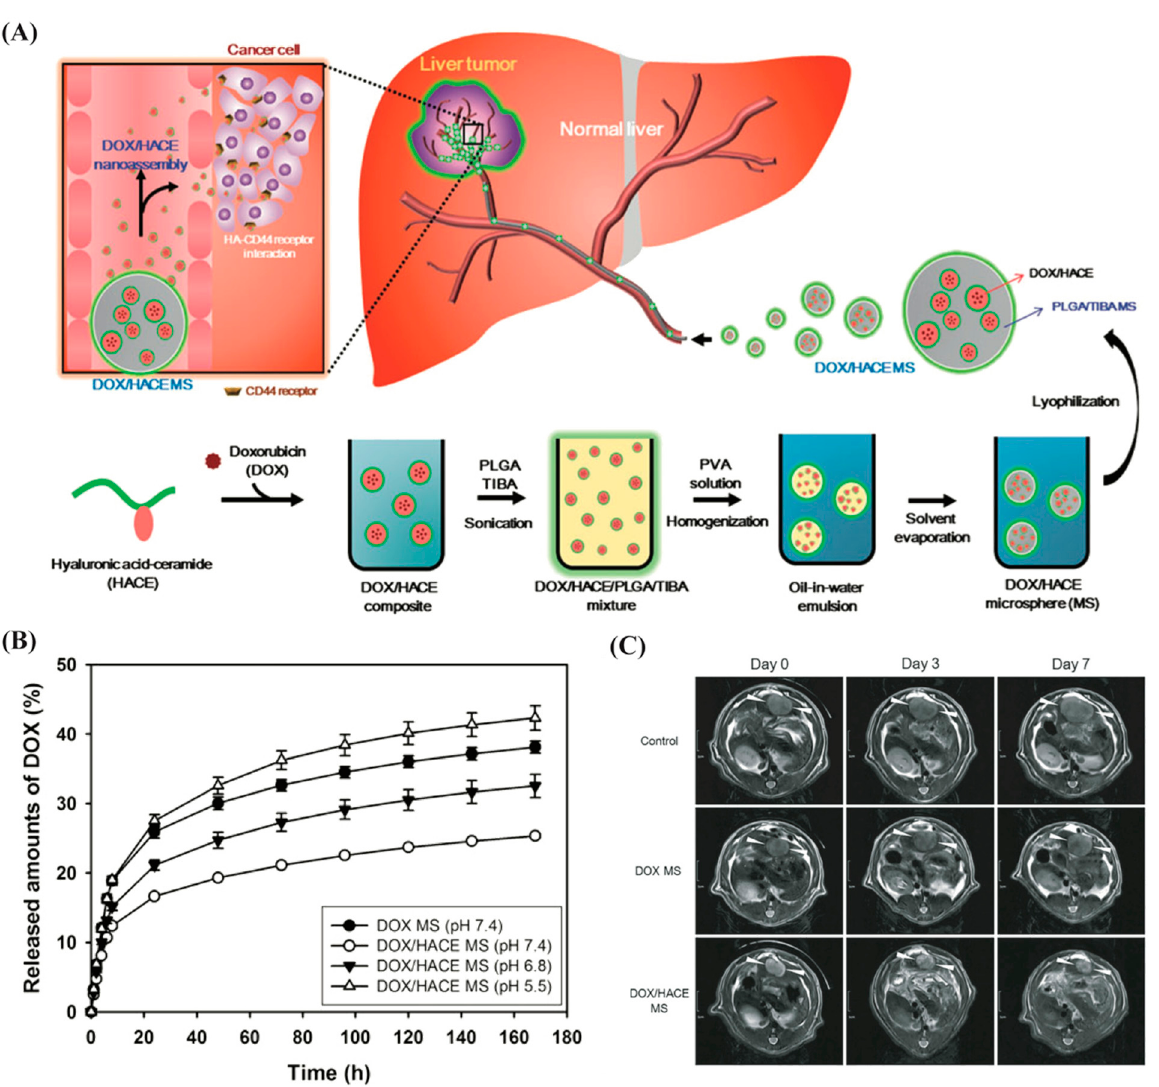
Figure 3. Doxorubicin (DOX)-loaded hyaluronic acid–ceramide (HACE) nanoassembly-releasing PLGA microspheres for TACE therapy of liver tumor. ( A ) Schematic outline of the DOX/HACE microsphere fabrication. ( B ) Drug release profiles from different microspheres at different pH (i.e., pH for DOX is 7.4, and pH for DOX/HACE are 7.4, 6.8, and 5.5). ( C ) Series of MR images of liver tumors in control (sham operation), DOX microspheres, and DOX/HACE microsphere groups on day 0 (pre-treatment), 3, and 7 after intra-arterial administration. Reproduced with permission from Ref. [100].